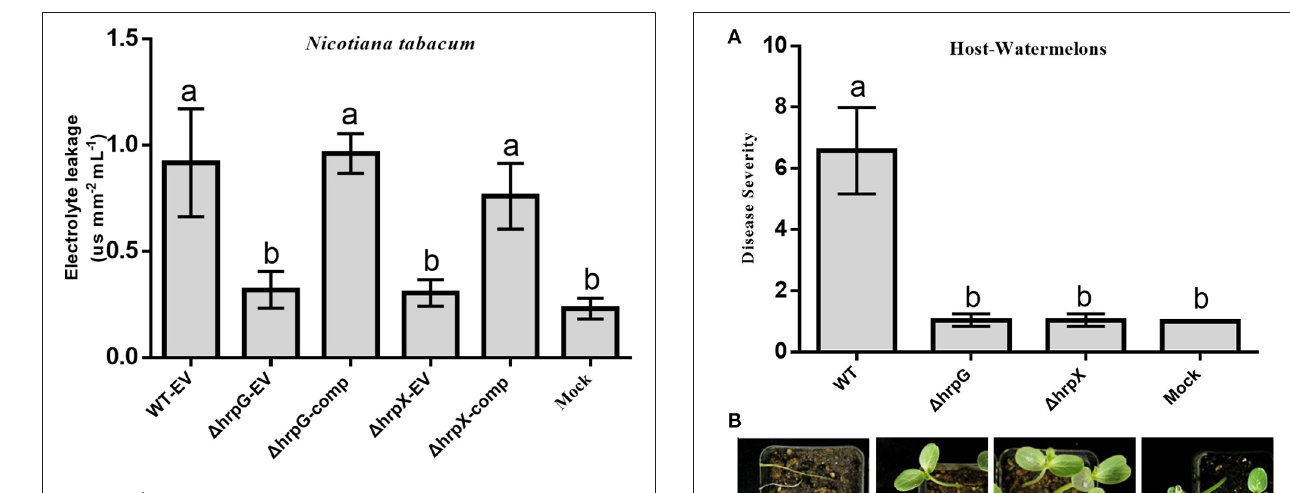
FIGURE 4 | Electrolyte leakage quantification assay for verification of hypersensitive response (HR) in Nicotiana tabacum induced by Acidovorax citrulli strains. Electrolyte leakage quantification for the detection of HR. Values are mean conductivity of bathing water ( µ S mm − 2 leaf ml − 1 bath water) ± standard deviation (SD) ( n = 3 plants). Different letters above bars indicate statistically significant differences as determined by one-way analysis of variance (ANOVA) and Tukey’s honest significant difference (HSD), p < 0.05.